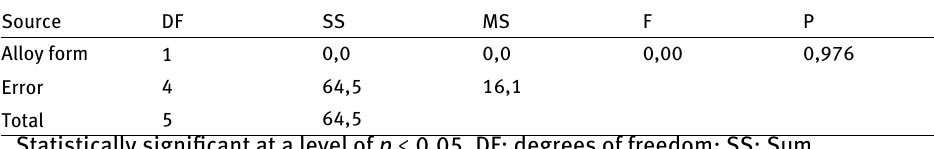
Table 4: Results of one-way ANOVA for tested conditions according to shear bond strength data. Source DF SS